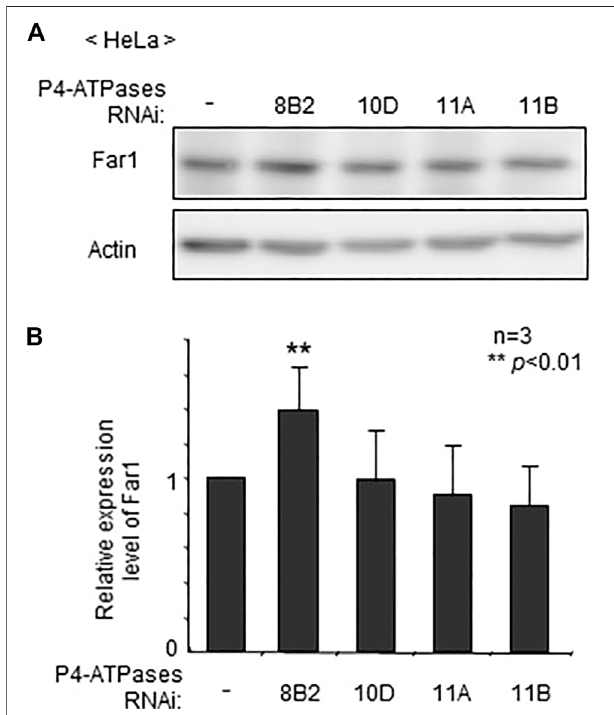
FIGURE1| Elevated protein level ofFar1 byknockdown of ATP8B2 . (A) HeLa cells were transfected with dsRNA against ATP8B2 (8B2), ATP10D (10D), ATP11A (11A), or ATP11B (11B) and cultured for 72 h. Protein level of Far1 and actin (Actin) was analyzed by immunoblotting with respective antibodies as indicated. Actin was used as a loading control. (B) The amount of Far1 was normalized by the actin level in respective transfectants and presented relative to that in non-transfected cells (-) ( n = 3). Data indicate means ± SD. ** p < 0.01 by Student ’ s t